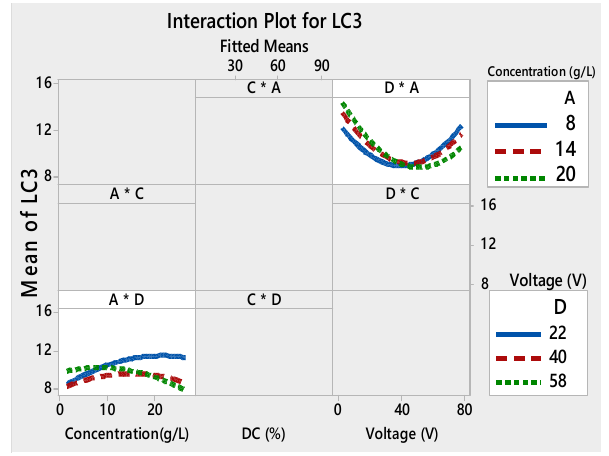
× )). Materials 2020 , 13 , x